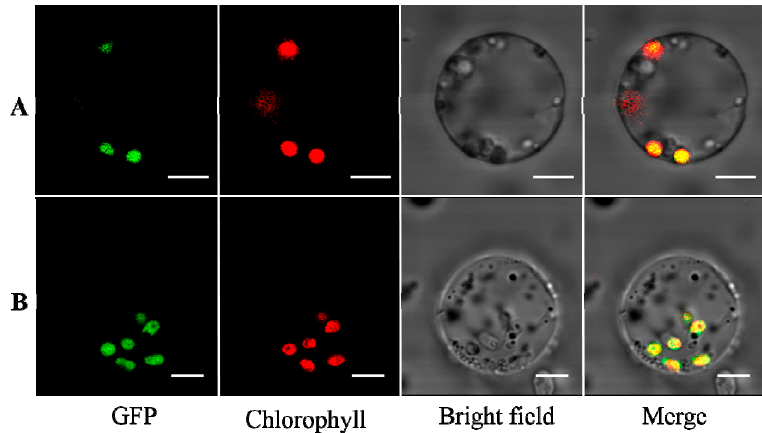
Figure 1. Subcellular localization of FJ643609-GFP ( A ) and EU586278-GFP ( B ) fusion proteins into rice protoplasts. Notes: (1) Full-length TaAGPS1b-FJ643609 and -EU586278 cDNA sequences were fused in-frame to GFP, respectively, and expressed under the control of the CaMV35S promoter. (2) All images were recorded at the same sensitivity and scale. (3) Each set of four images shows the same cell. Bars = 5 μ m.